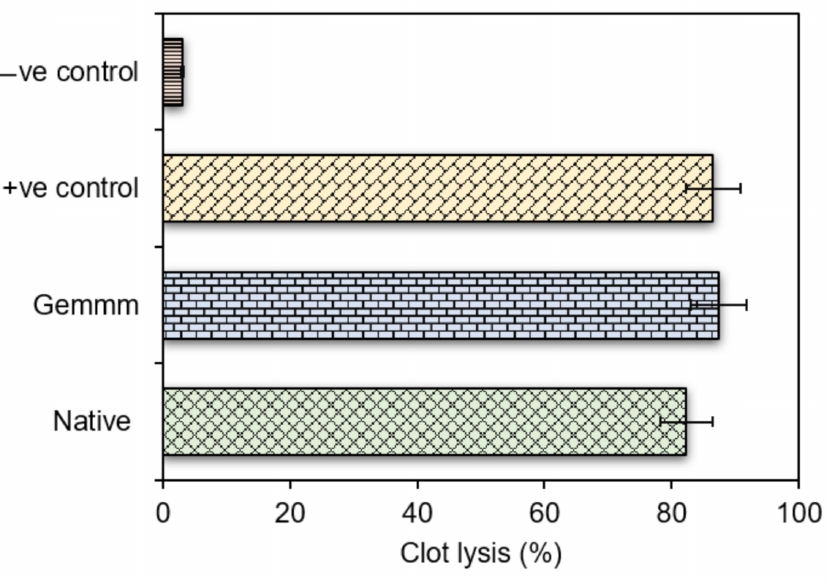
Figure 6. Percent (%) of thrombolysis of gemm and native extracts of H. griffithi